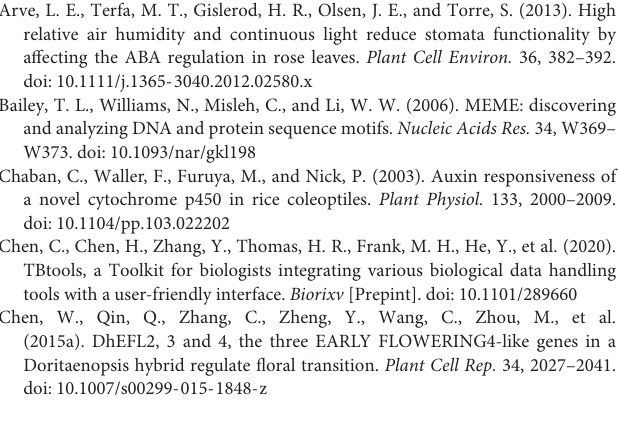
illustrating heatmaps. PLoS One 9:e111988. doi: 10.1371/journal.pone.0111988 Doyle, M. R., Davis , S. J., Bastow , R. M., McWatters , H. G., Kozma-Bognár,